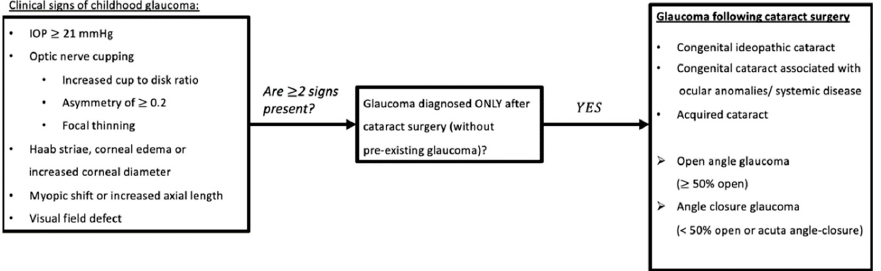
Figure 1. Glaucoma Following Cataract Surgery based on Childhood Glaucoma Research Network classification algorithm. Childhood: based on national criteria, <18 years old (USA); <16 years old (UK, Europe, UNICEF) (reproduced with permission from Grajewski, World Glaucoma Association Consensus Series 9: Childhood glaucoma, Kugler publications 2013 [5]). Abbreviations: IOP = Intra-Ocular Pressure.